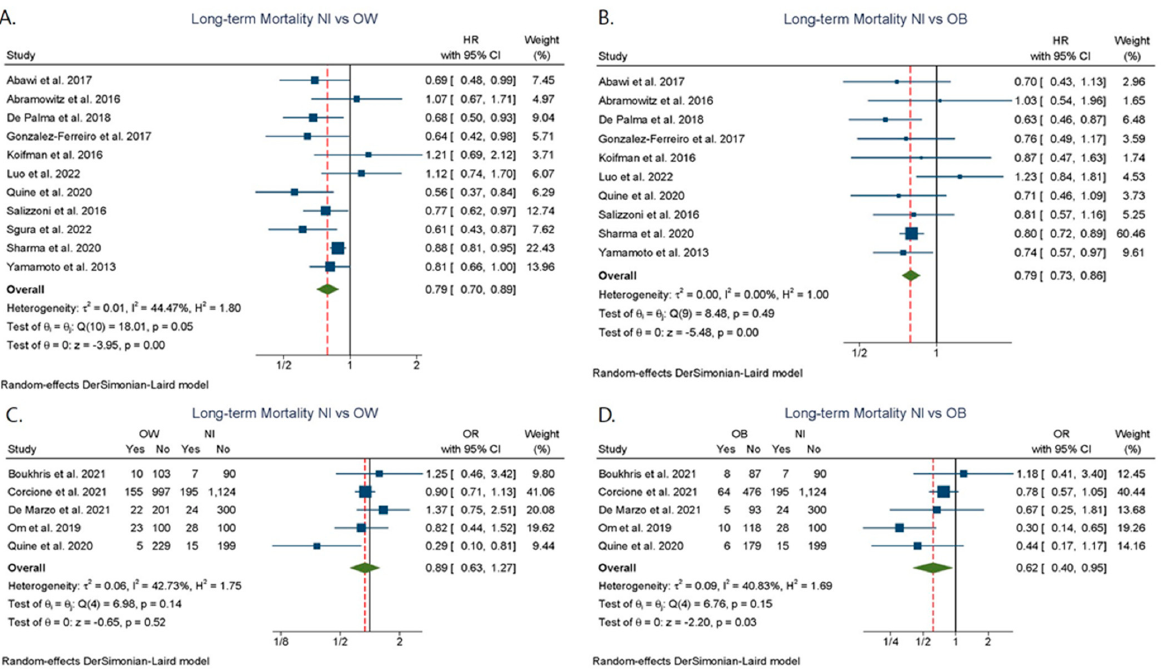
Figure 3. Long-term mortality after TAVR among different BMI categories. ( A ) Normal BMI vs. Overweight. ( B ) Normal BMI vs. Obesity. ( C ) Normal BMI vs. Overweight. ( D ) Normal BMI vs. Obesity. HR: hazard ratio; Nl: normal BMI; OW: overweight; OB: obesity; OR: odds ratio [9,12,23,24,26,27,29,31,34,35,37,39–41,43].